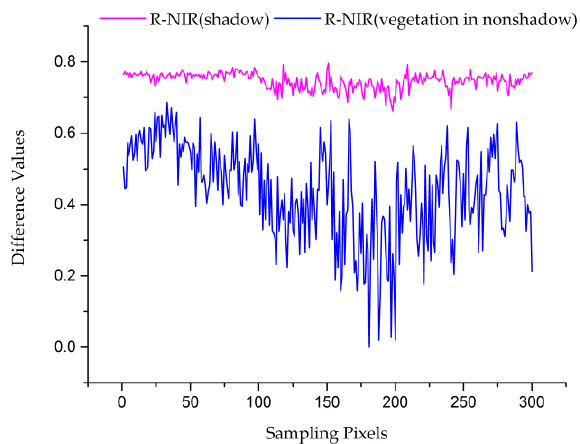
Figure 2. Sampling curves with respect to the reflectivity difference values between the normalized reflectivity values of the red (R) band and the near infrared (NIR) band for both shadow regions and vegetation cover types in nonshadow regions.